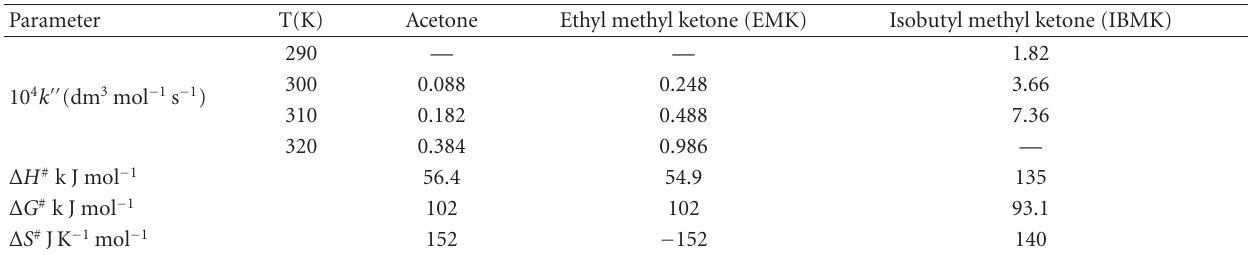
Table 5: E ff ect of temperature. Activation Parameters for unanalyzed system.